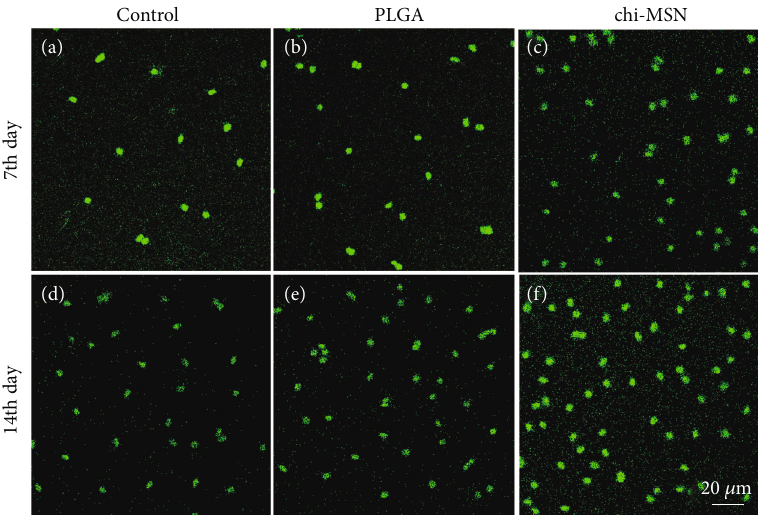
Figure 4: BMSC activity evaluation. (a – c) Anti-Ki67 expression in control, PLGA, and Chi-MSN groups at 7th day. (d – f) Anti-Ki67 expression in control, PLGA, and Chi-MSN groups at 14th day.